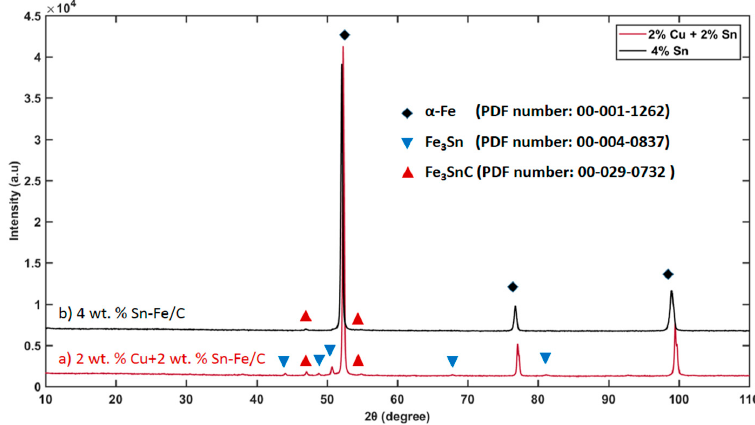
Figure 1. XRD patterns of the a) CuSn and b) Sn samples.